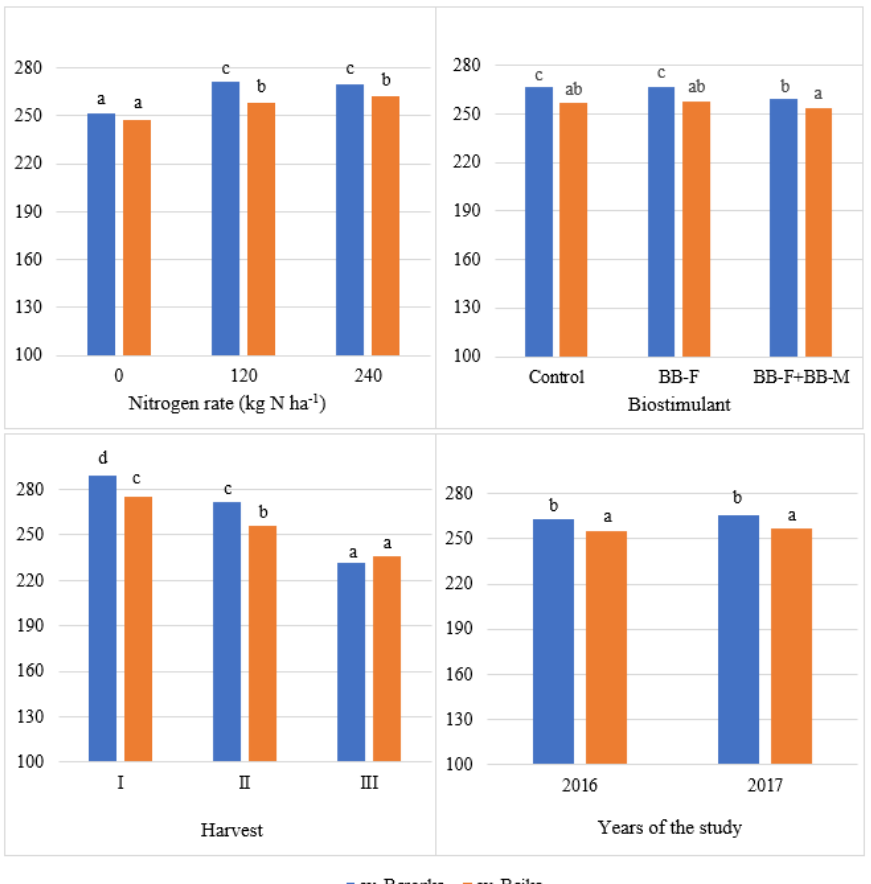
Figure 2. Relationships between the content of crude fiber (g kg − 1 DM) in the post-harvest biomass of the analyzed perennial ryegrass cultivars vs. nitrogen rate, biostimulant and years of the study (the same letter do not differ significantly at p < 0.05 in Tukey’s HSD